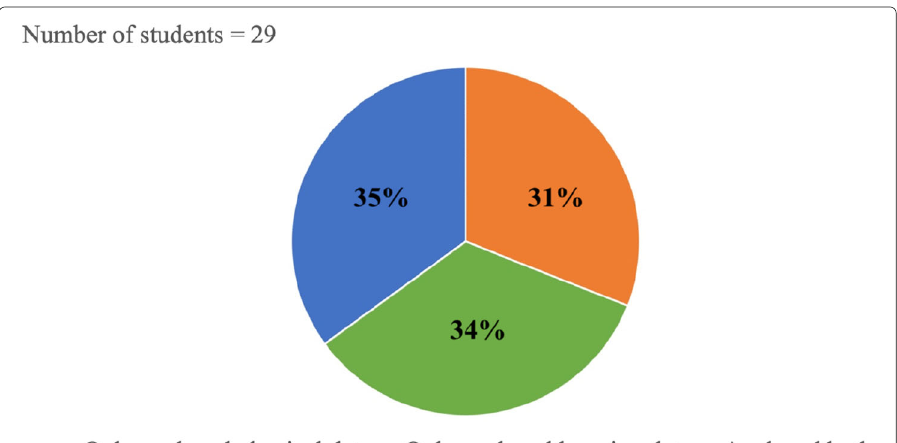
Fig. 7 Proportion of different